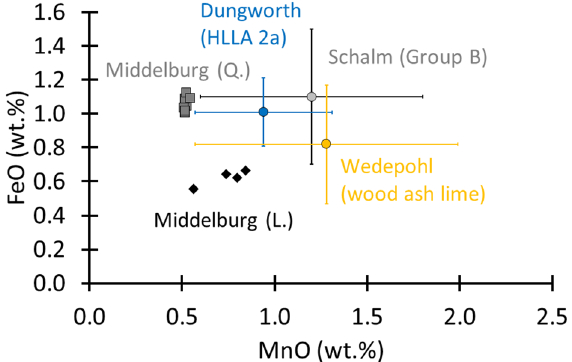
Figure 6. The Mn-Fe chart shows that the lozenge material (filled diamond) has lower iron levels compared with the Group B material that Schalm reported. Meanwhile, the quadrangular material (filled square) unveils iron and manganese levels which are close to those of the Group B material of Schalm and the HLLA 2a group of